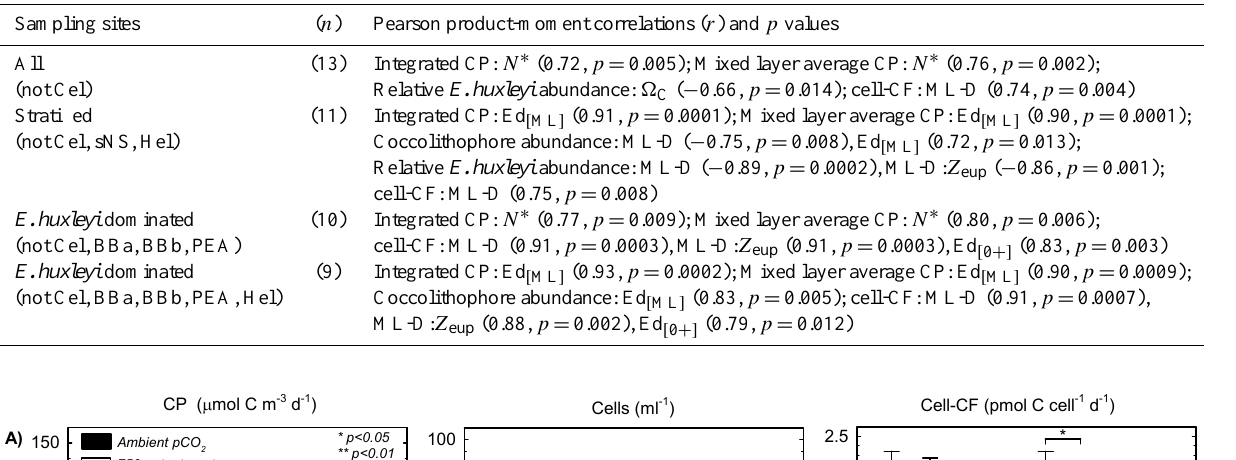
Table 4. Summary of statistically significant ( p < 0.01) correlations between coccolithophore dynamics and environmental conditions across different sets of sampling stations.